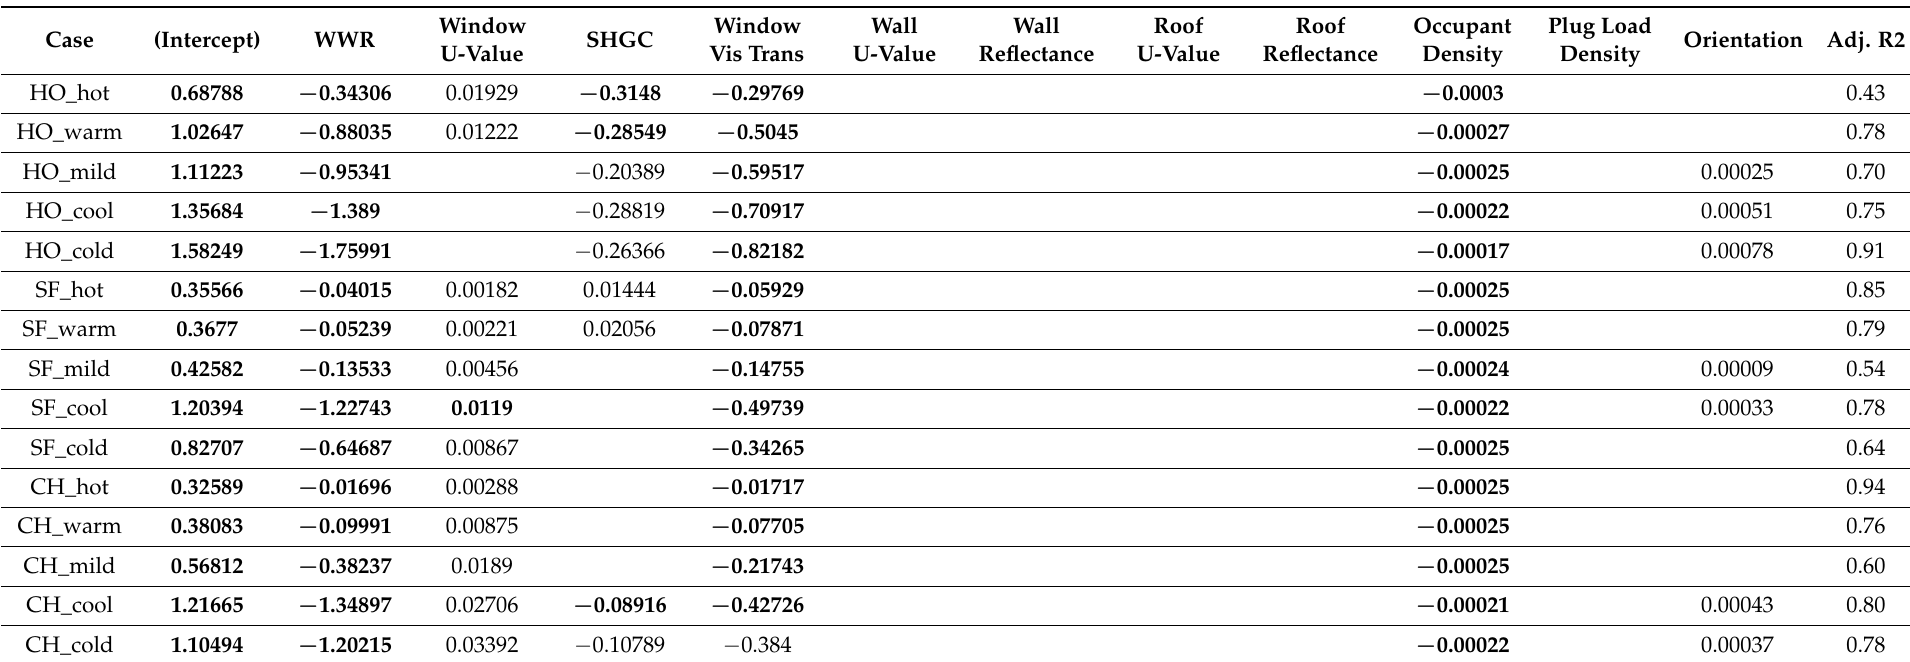
Table A4. Visual OHL Regression